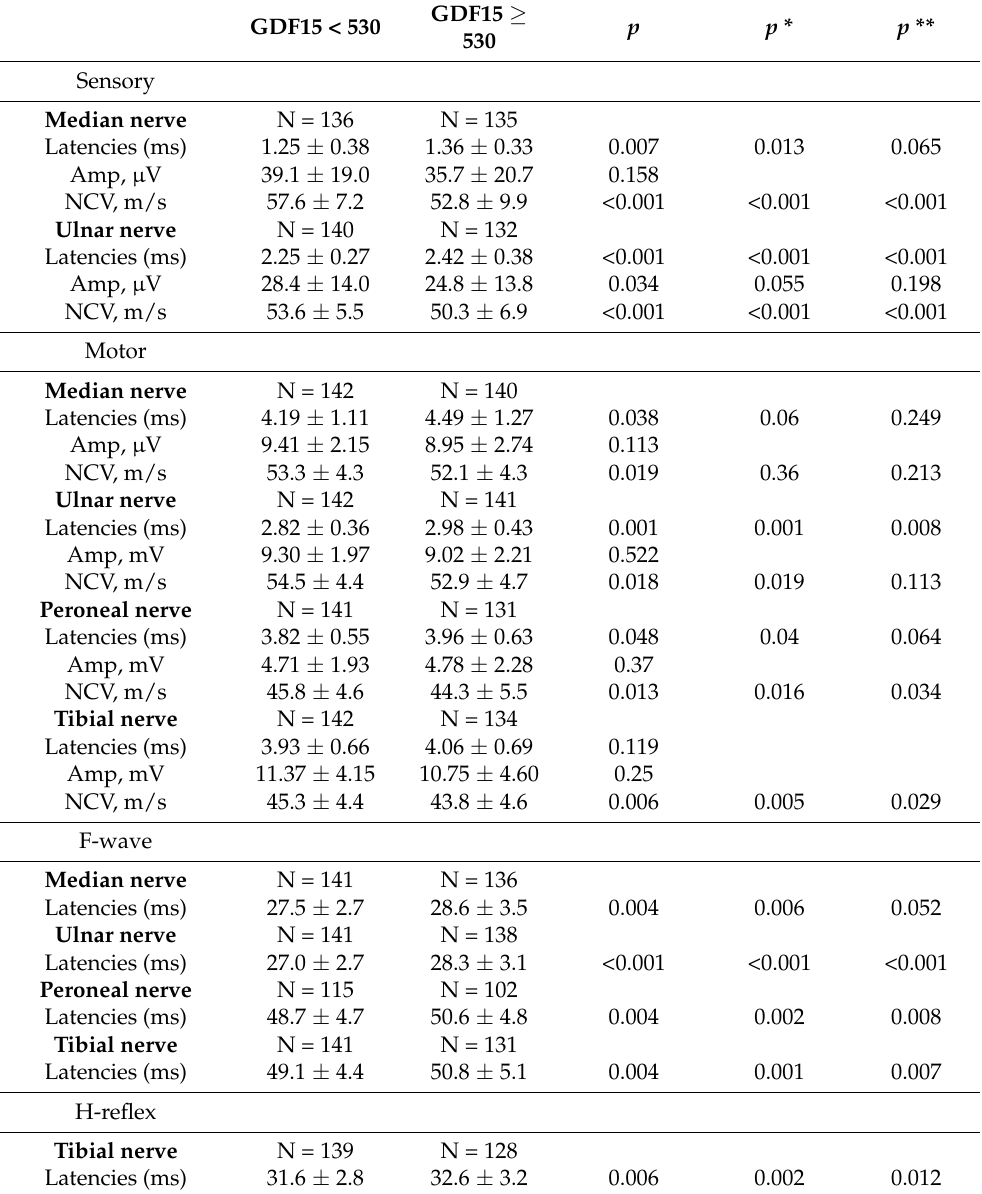
Table 4. Comparisons between GDF grading and nerve conduction